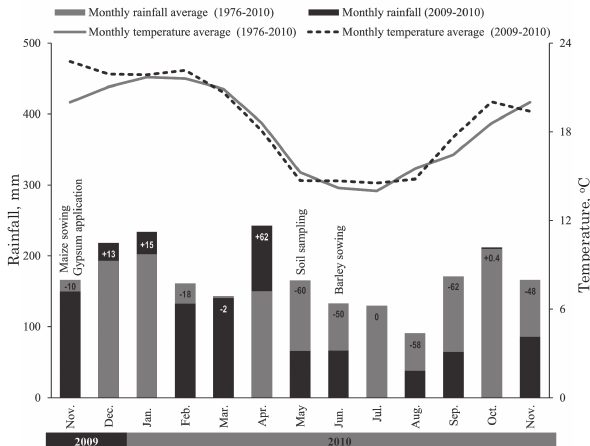
Figure 1. Historical (1976-2010) and observed (Nov/ 09 to Nov/10) averages of rainfall and temperature at Guarapuava, Parana, Brazil. Values inside the bars indicate the difference (%) between historical and observed rainfall during the experimental